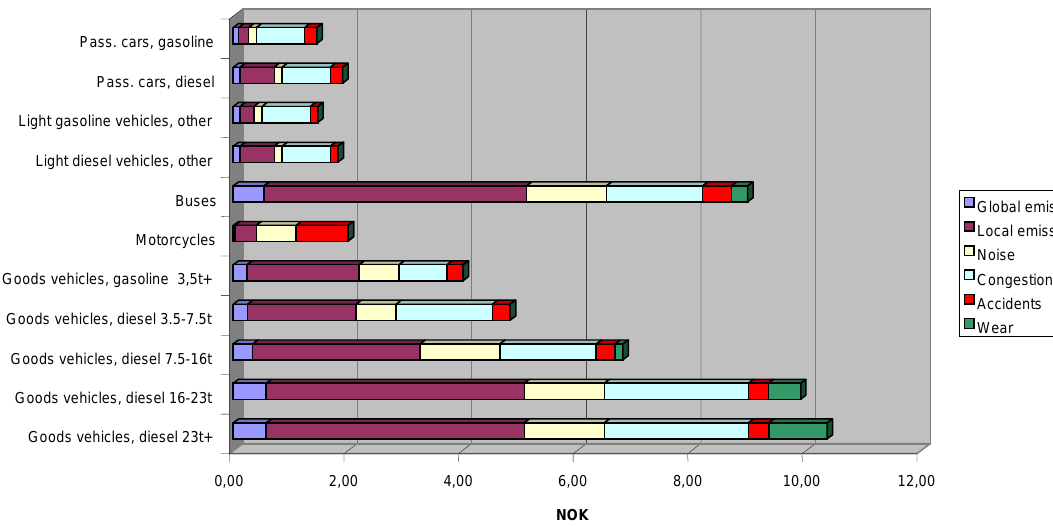
Figure 5. Marginal external costs per vehicle km.